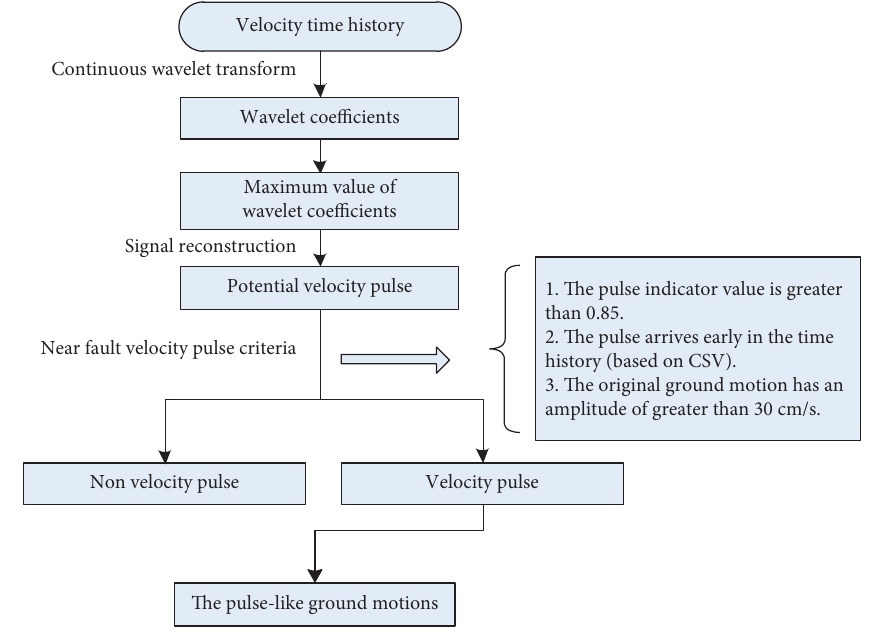
Figure 1: The flowchart of improved Baker method.